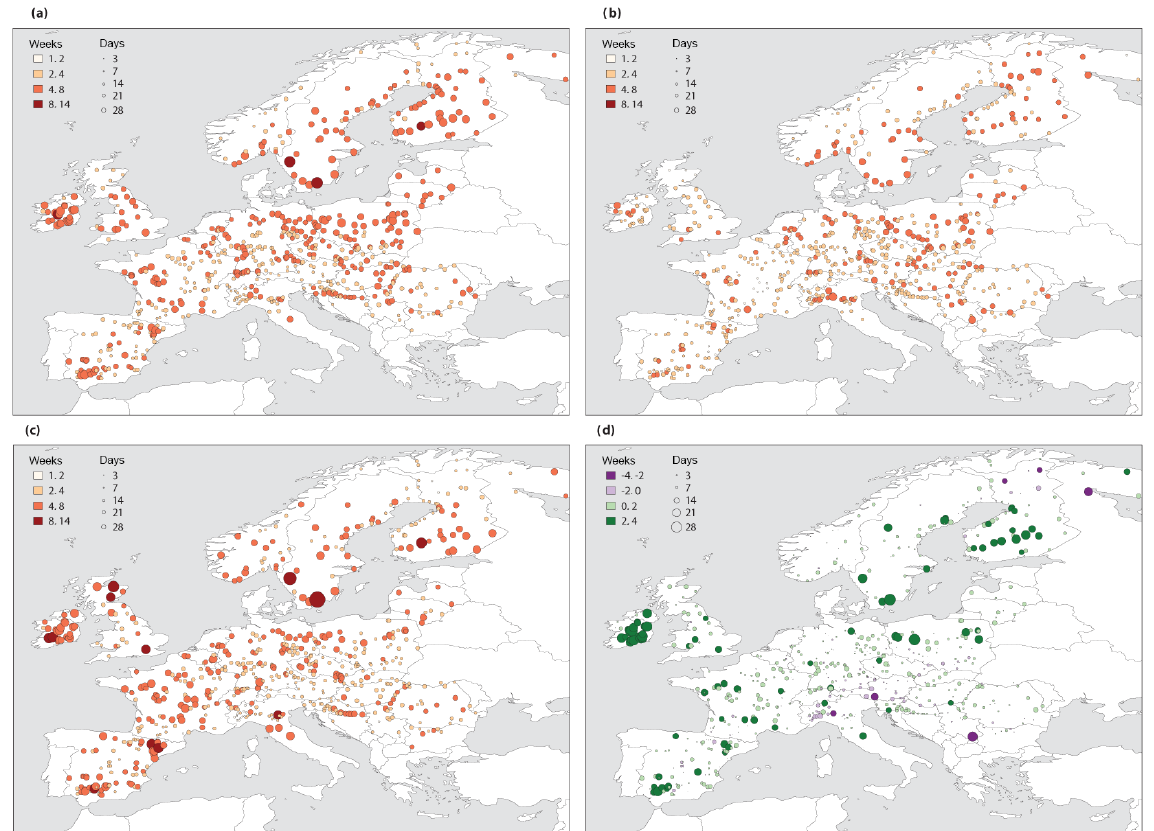
Figure 4. The number of weeks (days) before the CRPSS goes below zero using only the first forecast of the month for (a) SEAM against CLIM; (b) SYS4 against CLIM; (c) SEAM against SYS4; and (d) difference between SEAM against CLIM and SYS4 against CLIM. The dimension of the circles is proportional to the number of days while the color scale refers to the number of weeks. The size and color of the circles are therefore showing the same information, and are both added for clarity.